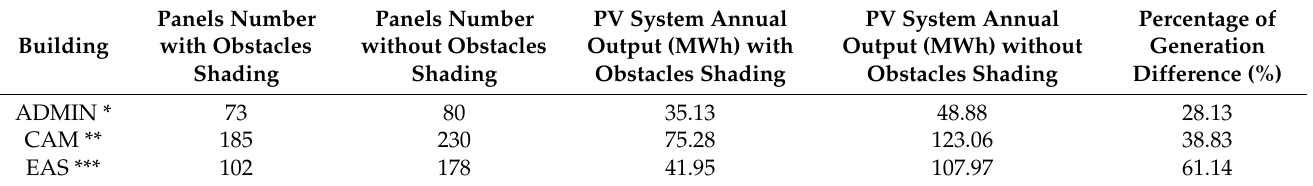
Table 4. Comparison of obstacles shading effect on the PV systems’ generation and modules